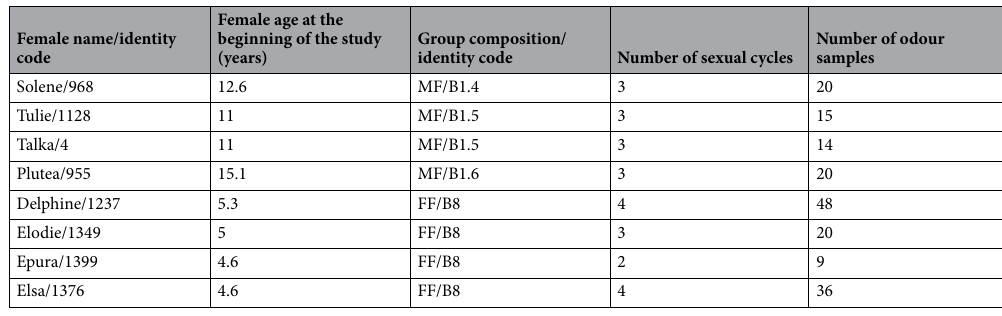
Table 1. Study subjects at the beginning of data collection. The dataset was reduced from 12 to eight female baboons in order to preserve vaginal odour samples for future work.